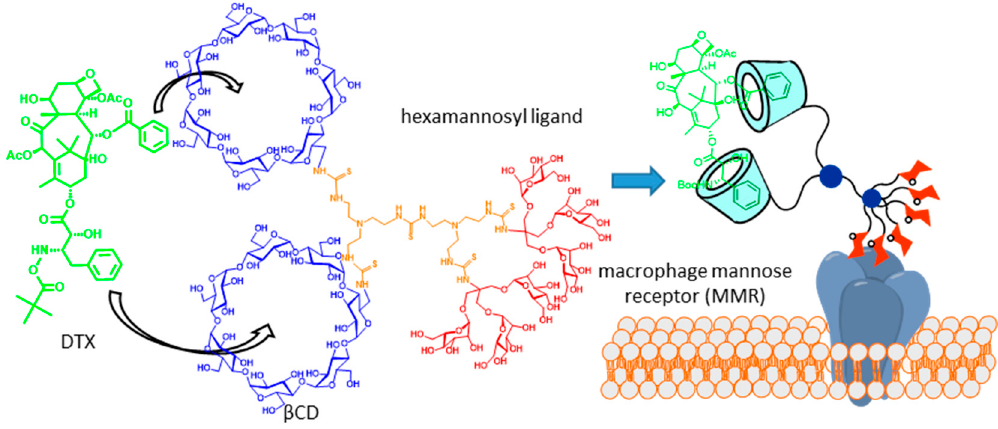
Figure 2. Docetaxel (DTX) carrier consisting of a hexamannosylated dimeric β CD derivative designed on the basis of the drug clusterization concept [35]. Adapted with permission from Reference [3]. Copyright 2013 Royal Society of Chemistry.